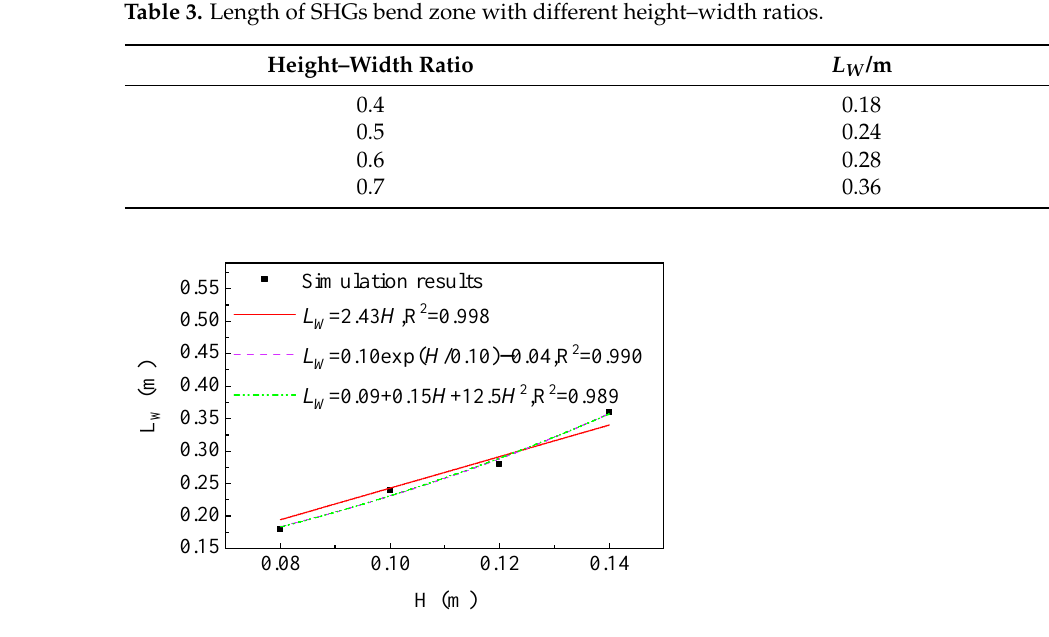
Figure 8. Formula fitting of bend zone